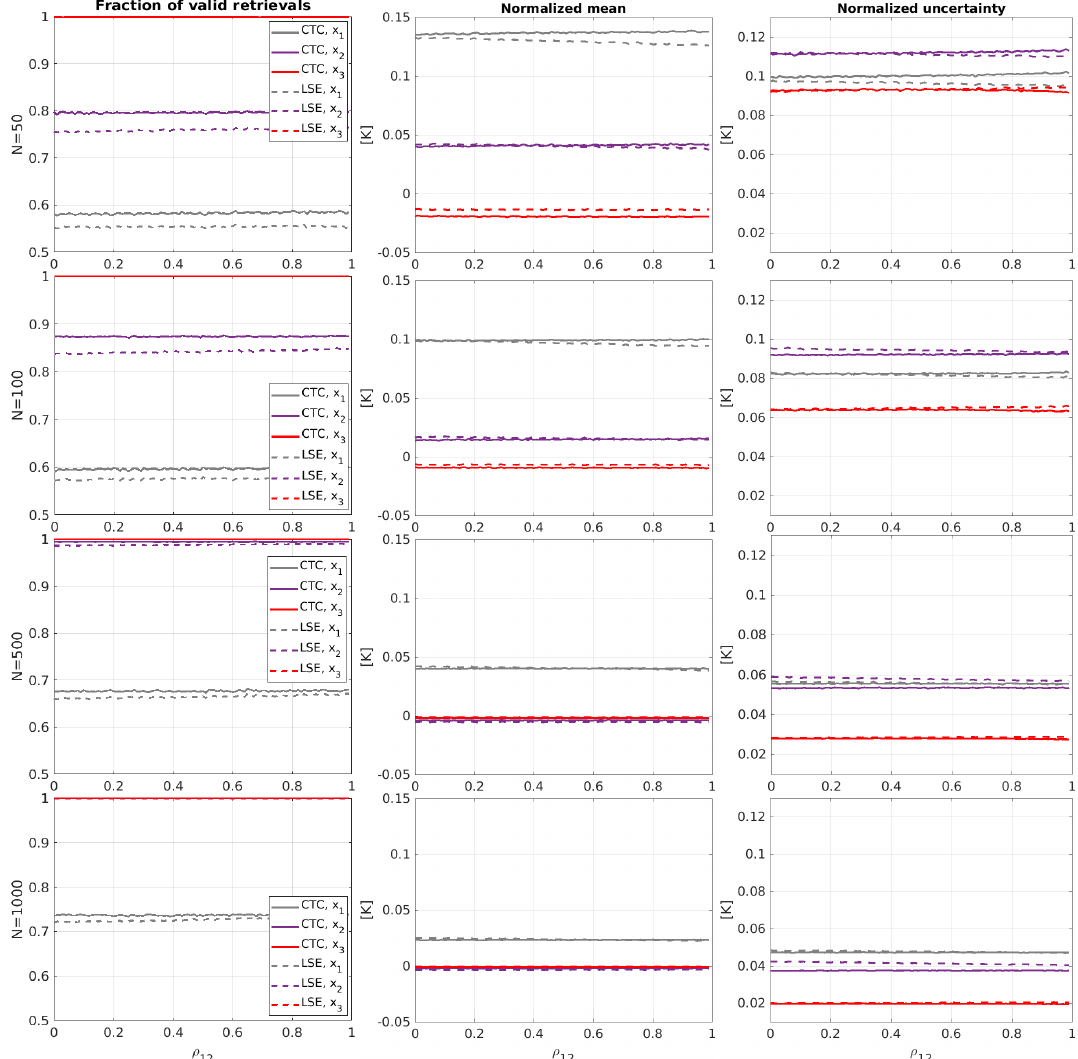
= 0.1, σ = 0.25, and σ = 0.5): δ 2 δ 3 1